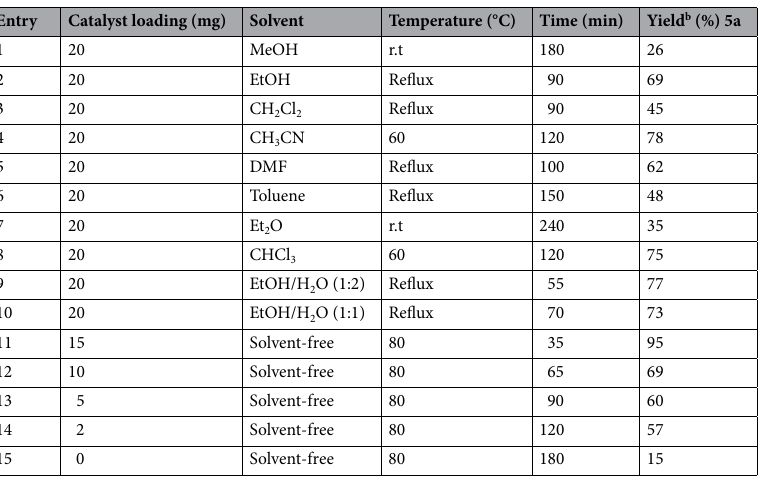
Table 1. Optimization of conditions in the model reaction of ethyl acetoacetate ( 2 ), 4-chlorobenzaldehyde ( 3a ), urea ( 4 ) under different conditions in the presence of MCM-41-APS-PMDA-NHSO 3 H ( 1 ).